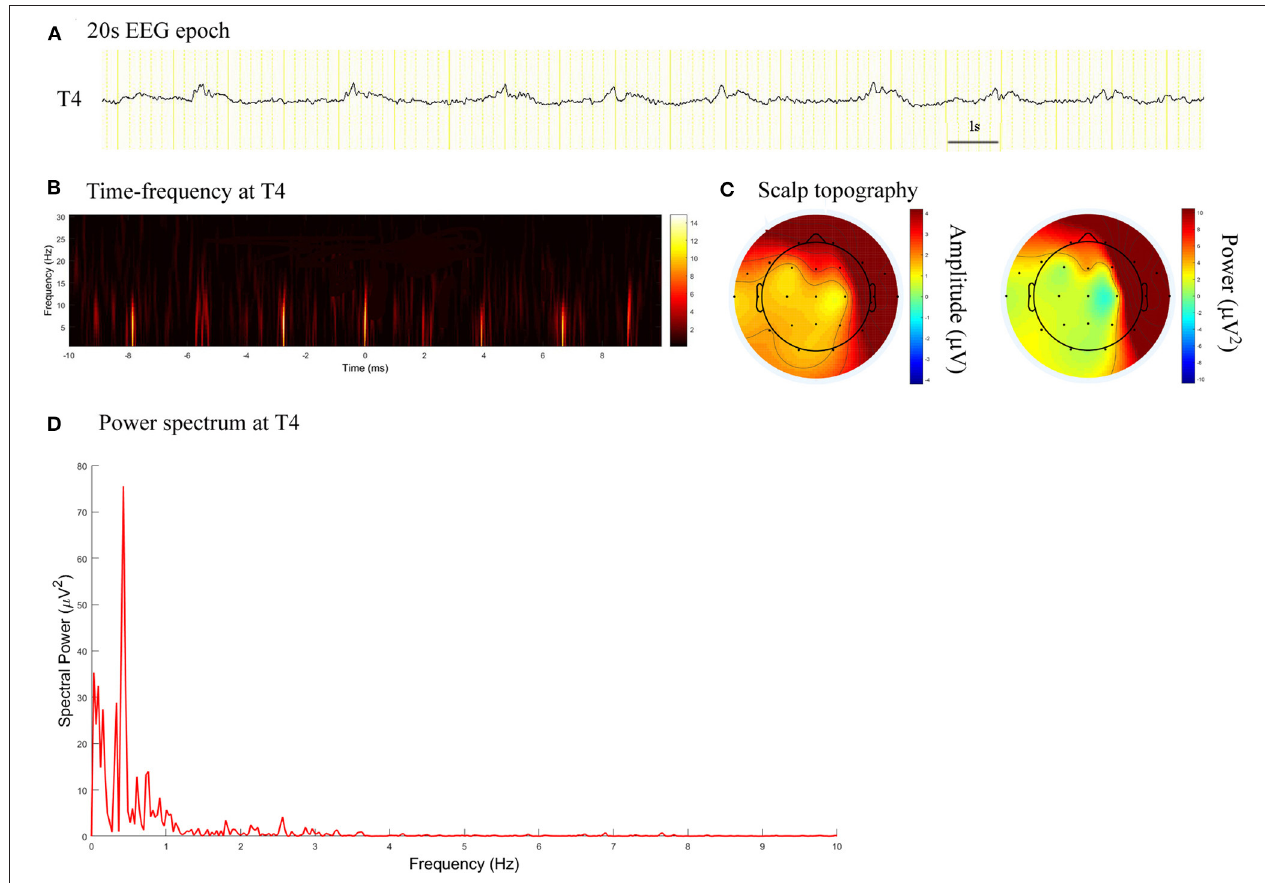
FIGURE 2 | EEG epoch, time-frequency and power spectrum analysis, and scalp topography in a patient with acute viral encephalitis. (A) A 20s EEG epoch at T4 electrode. (B) Time-frequency analysis showed the PDs pattern had a frequency of 0.4Hz. (C) Scalp topography showed the PDs pattern located in the right temporal regions. (D) Spectral power value for PDs of 20s at 0.4Hz was 75.52 µ V 2